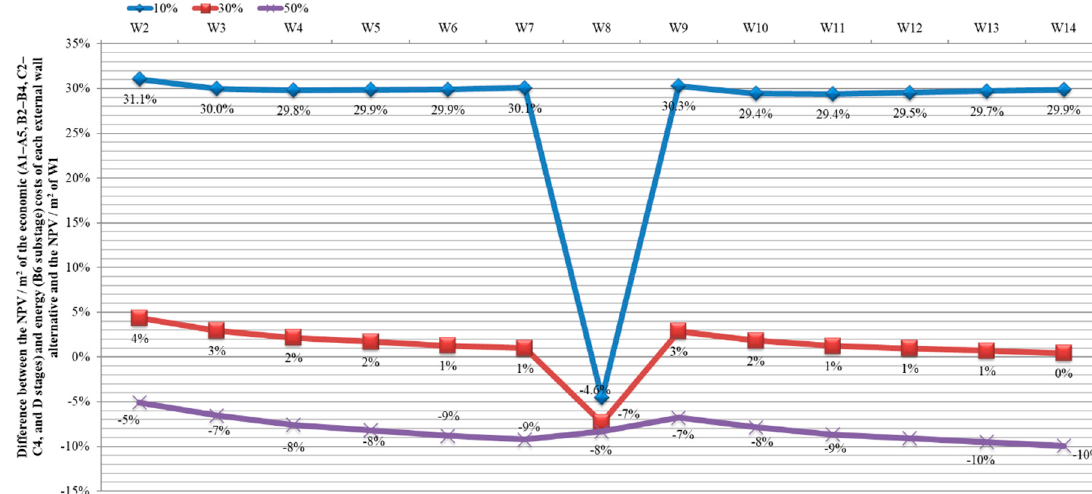
Figure 6. Difference between the NPV/m 2 of external wall of the economic (A1–A5, B2–B4, C2–C4, and D stages) and energy (B6 substage) costs of each external wall alternative and the NPV/m 2 of W1, considering different consumption patterns for the use stage (guaranteeing 10%, 35%, or 50% of the energy needs) of ETICS with